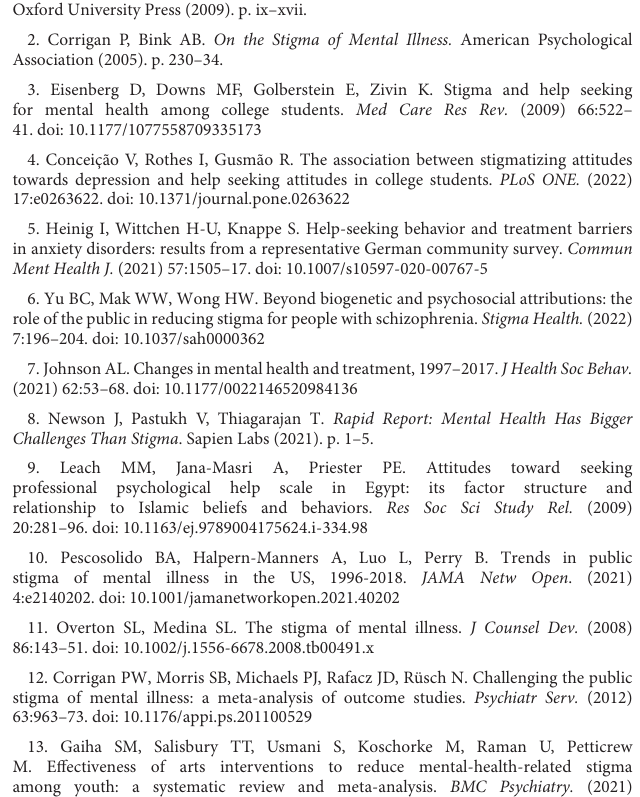
Table 1. All authors contributed to the article and approved